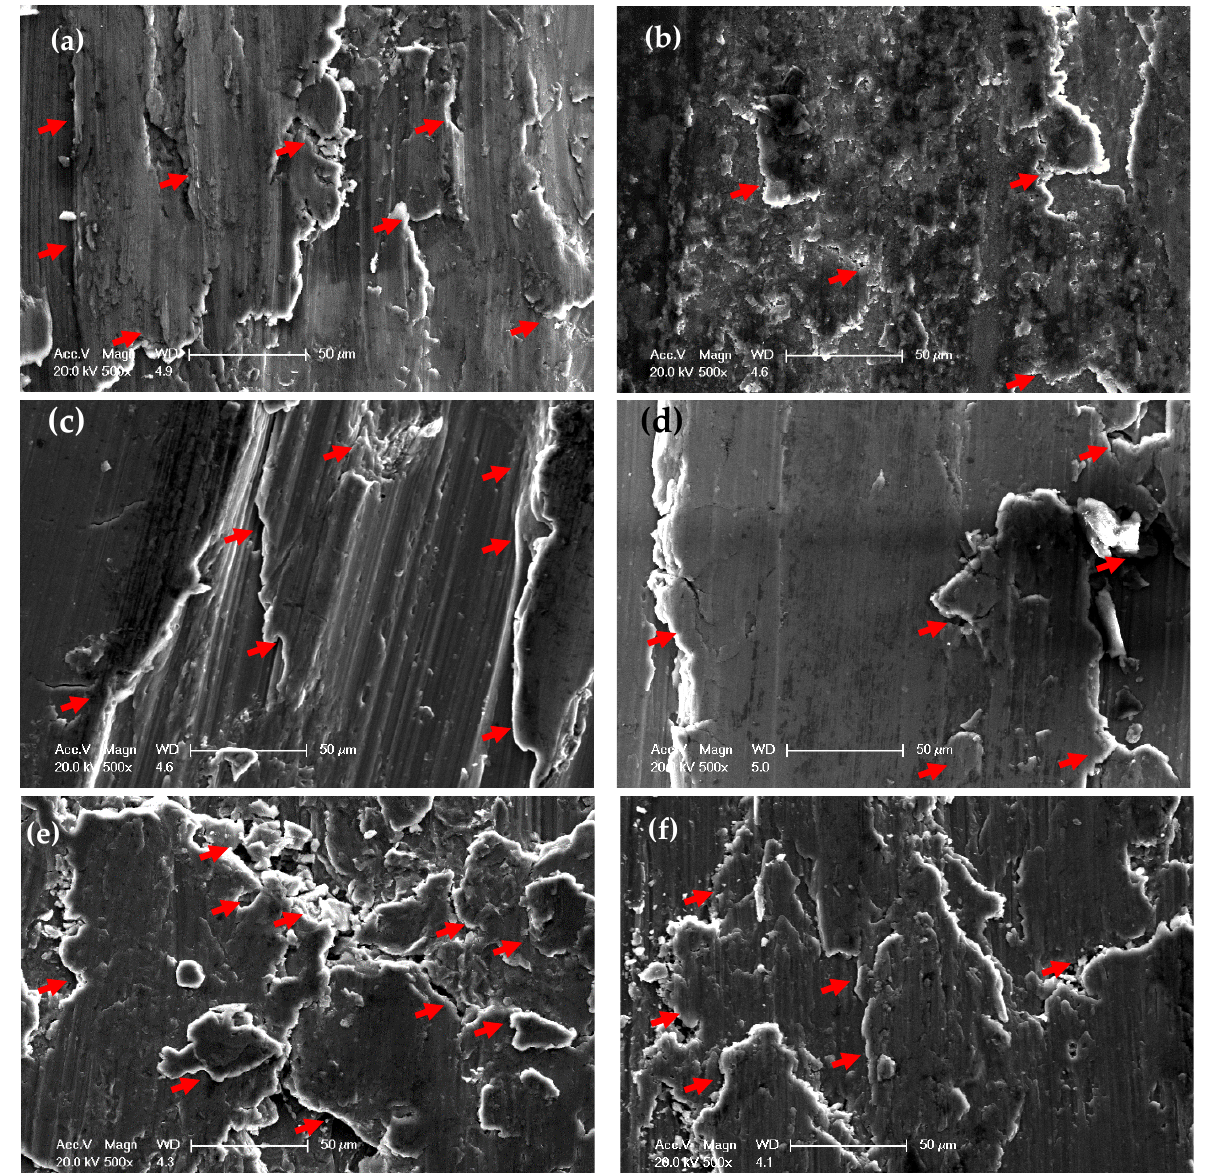
Figure 7. Worn surface morphology of ( a , c,e ) PM Al and ( b , d , f ) of HPT-processed Al, samples ( a , b ) under an applied load of 2.5 N and a sliding distance of 315 m, ( c , d ) under an applied load of 20 N and a sliding distance of 315 m, and ( e , f ) obtained under an applied load of 20 N and a sliding distance of 1260 m.